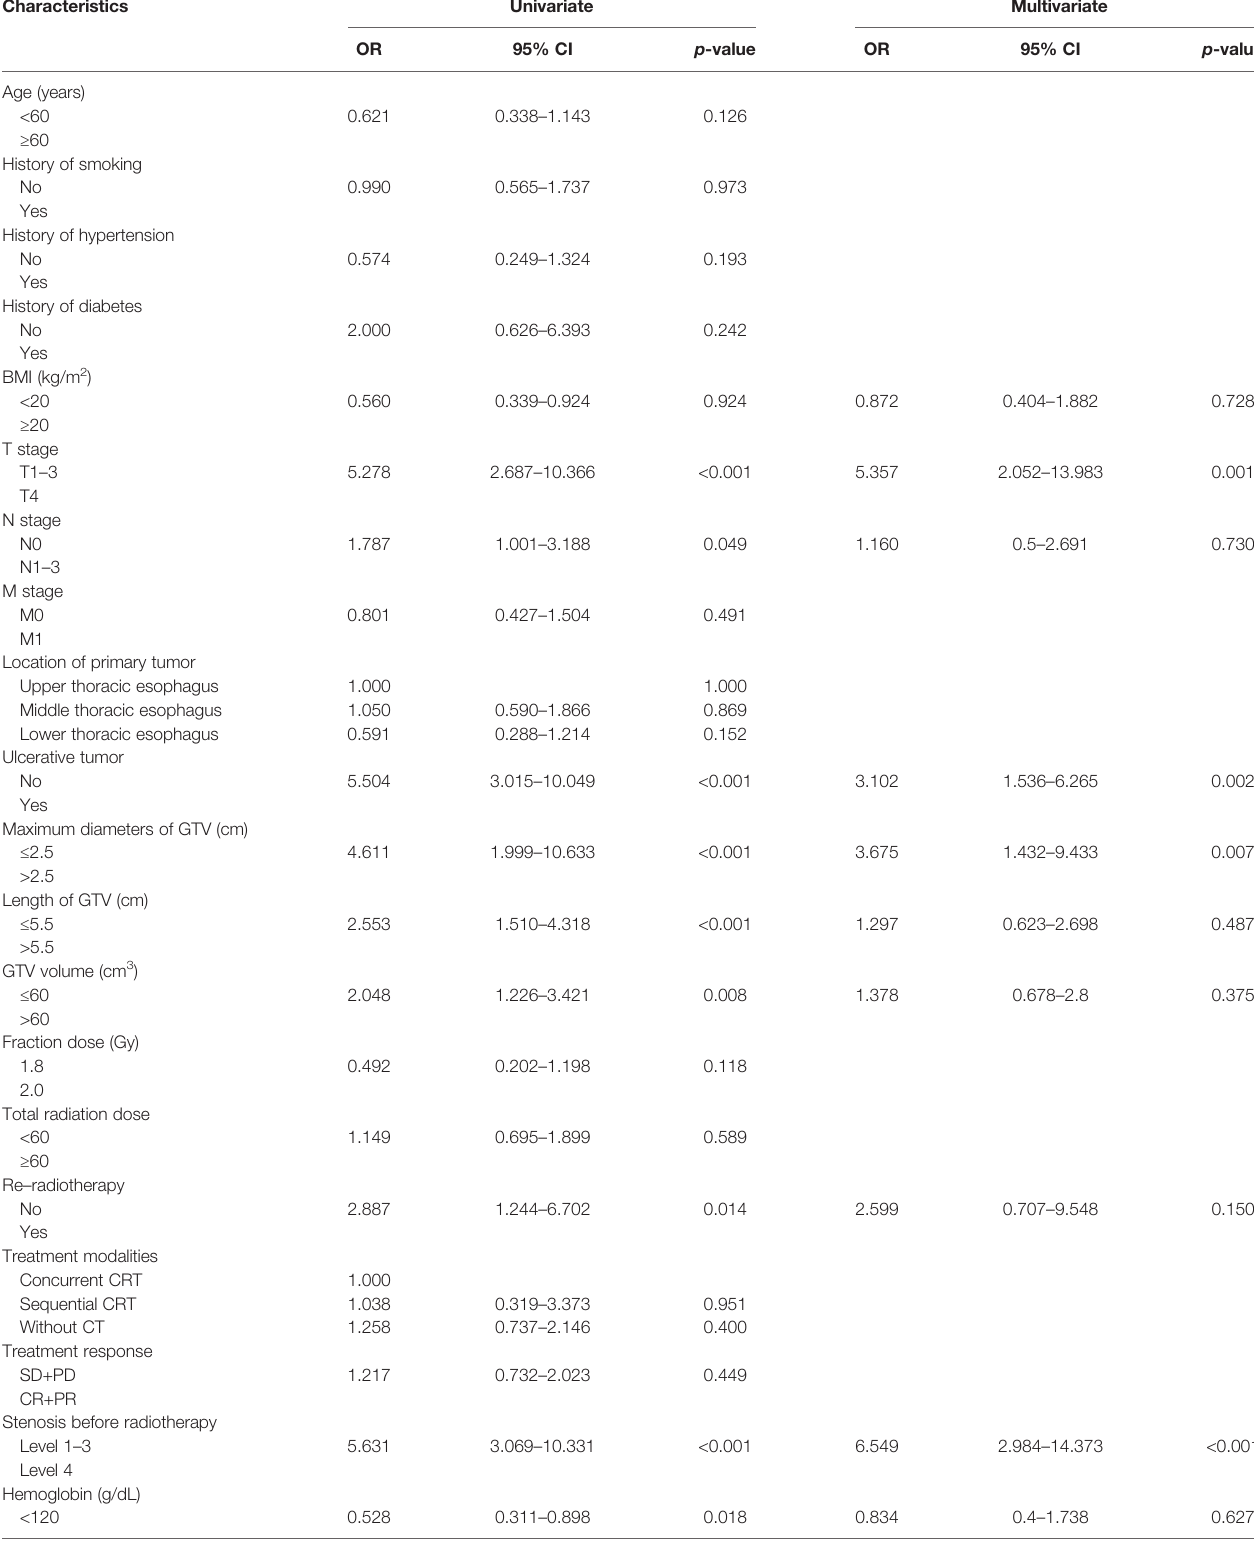
TABLE 2 | Univariate and multivariate analysis of the factors associated with esophageal fi